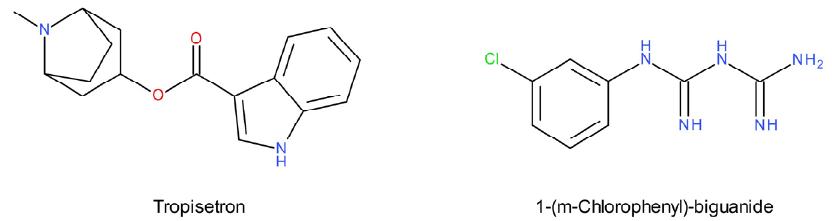
Figure 7. 5-HT 3 receptor ligands: tropisetron and mCPGB.